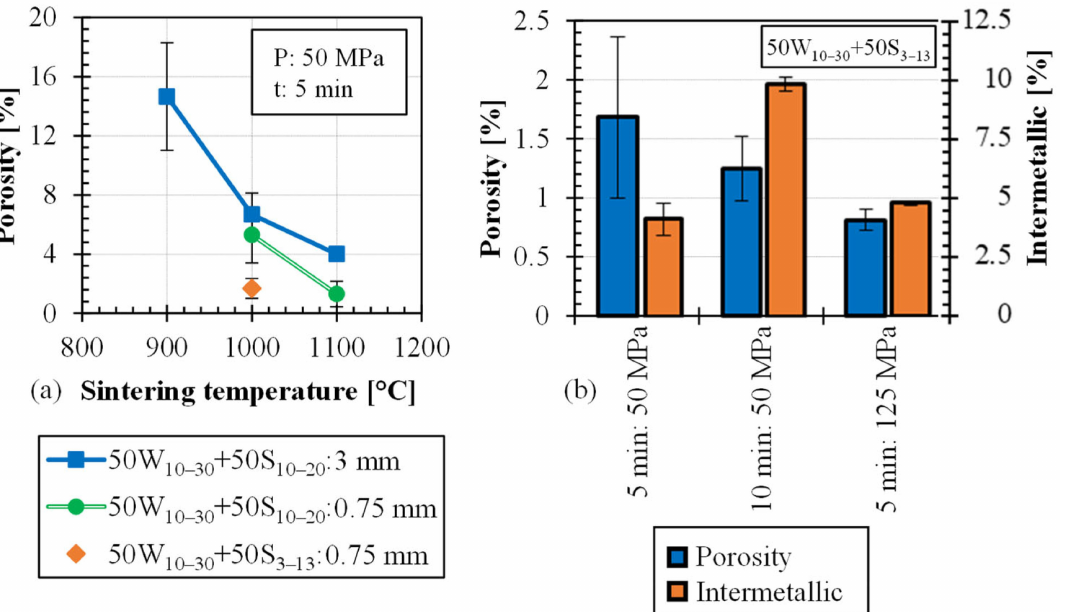
50 W composite were found to be 1000 ◦ C; 125 MPa; 5 min, and using the 50W 10–30 +50S 3–13 SEM micrographs are provided in Figure S6 in Supplementary